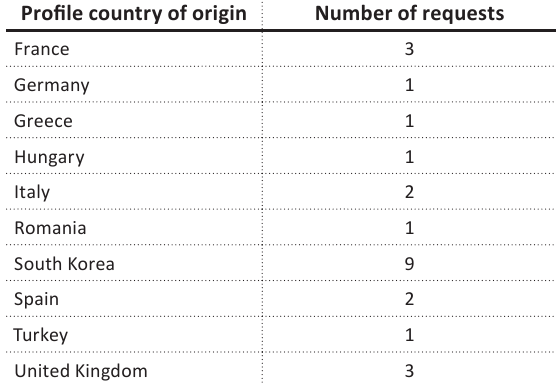
Table 3. The number of profiles of entrepreneurs by market sector “Communications” in the EEN system, which are interested in cooperation with Ukraine for the first half of 2019